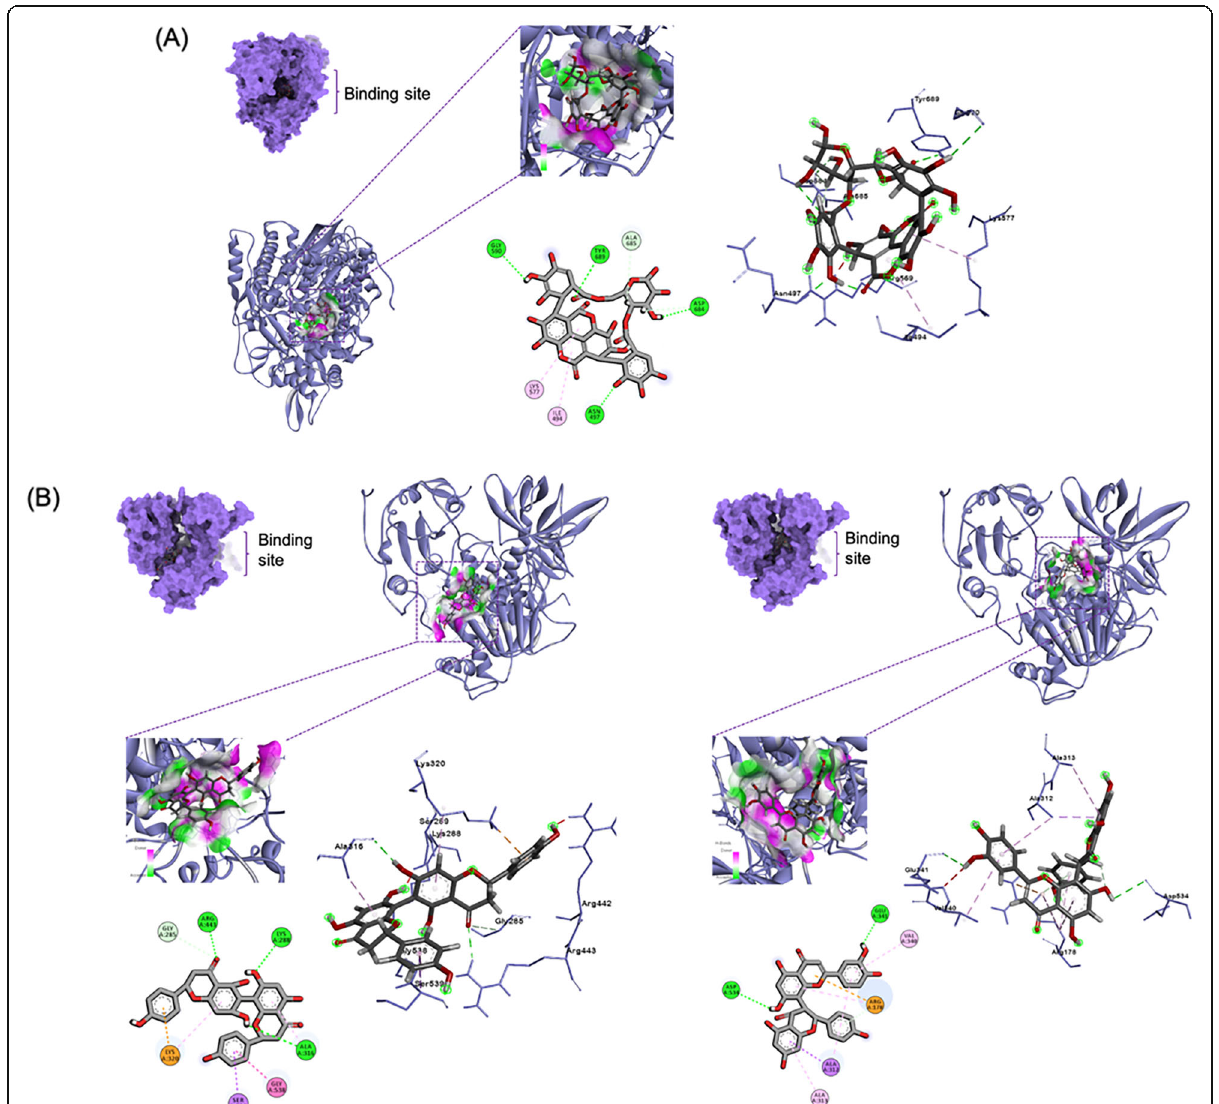
Fig. 3 Top 1-binding compounds in complex with their target enzymes vital in replication: A punicalin ( 9 ) in complex with RdRp, B rhusflavanone ( 13 ) (left) and morelloflavone ( 14 ) (right) bound to